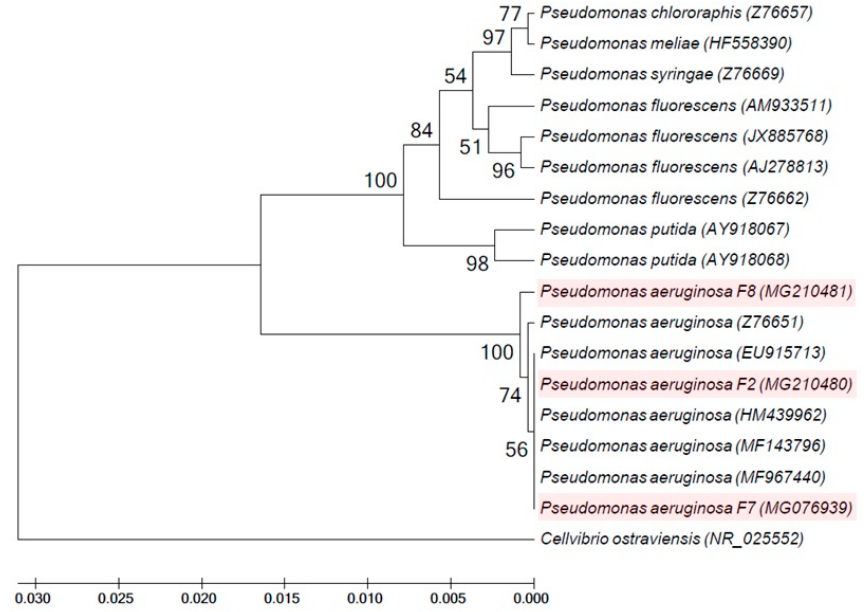
Figure 2. Phylogenetic tree of fluorescent Pseudomonas isolates F2, F7 and F8 obtained in the current study and validly described members of the genus Pseudomonas based on the nucleotide sequences of the 16S rRNA gene. Phylogenetic tree was constructed with UPGMA method using MEGA version 5 and the number of bootstraps replications is 2000.